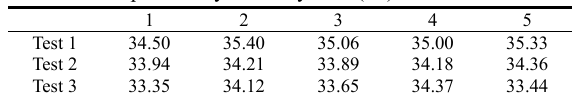
Table 1 Repeatability of the system ( ℃ )